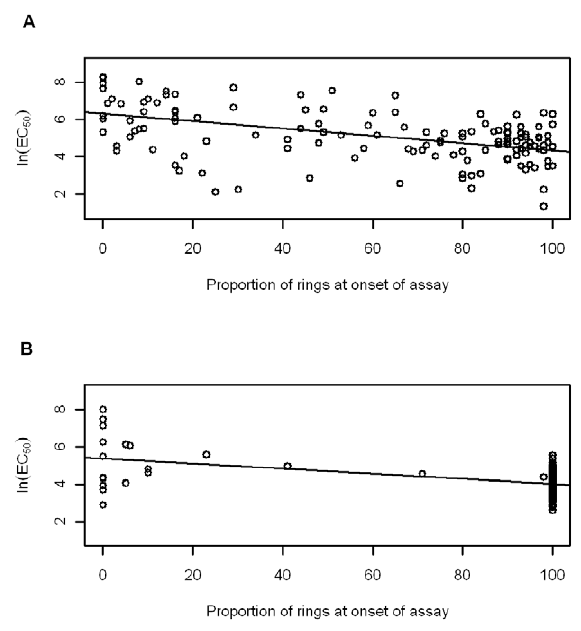
Figure 1. Relationship between assay duration and ln(EC 50 ). The figure depicts relationships for (A) P. vivax (n=141) and (B) P. falciparum (n=216).